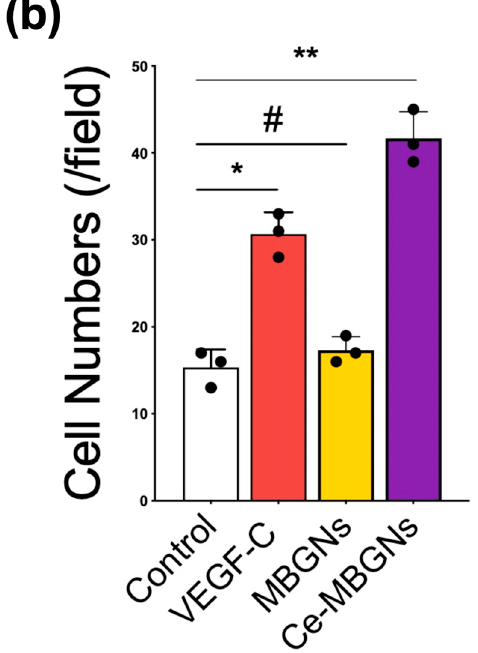
Figure 5. Images of Transwell migration assays ( a ) and quantitative analysis of migrated cell numbers ( b ) showing the migration ability of LECs cultured with conditioned media VEGF-C (50 ng/mL), MBGNs (1 wt/v% extract), and Ce-MBGNs (1 wt/v% extract). Scale bar = 200 μ m. The experiment was performed at least in triplicate independently with three technical repeats. p < 0.05 (*), p < 0.01 (**) and p > 0.05 (#).